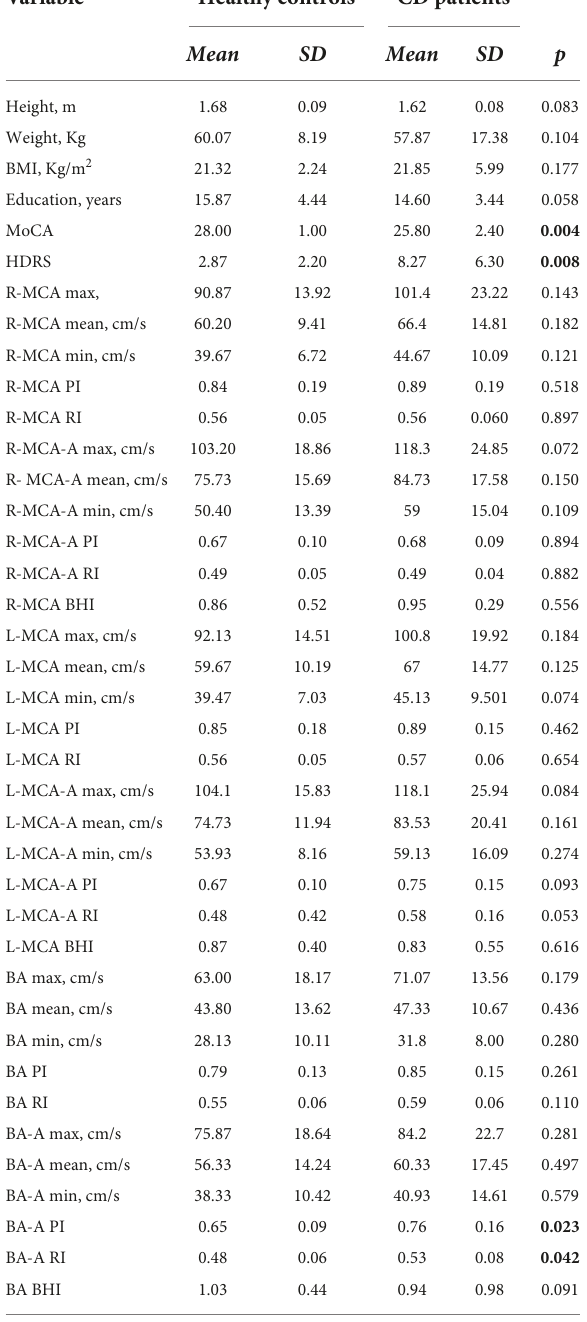
TABLE 2 Demographic data and TMS features of the two groups of